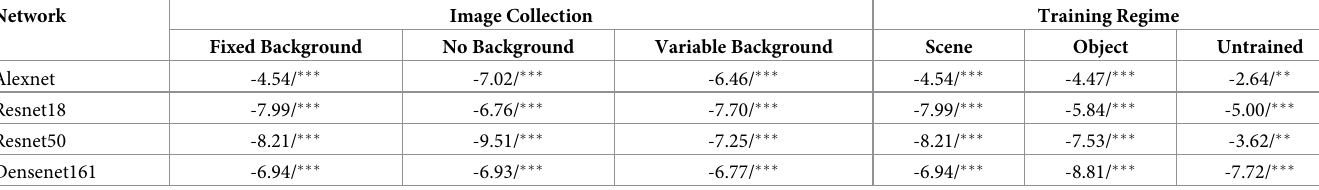
Table 5. Paired, one-tailed t-test results comparing differences in index measures between the first and final